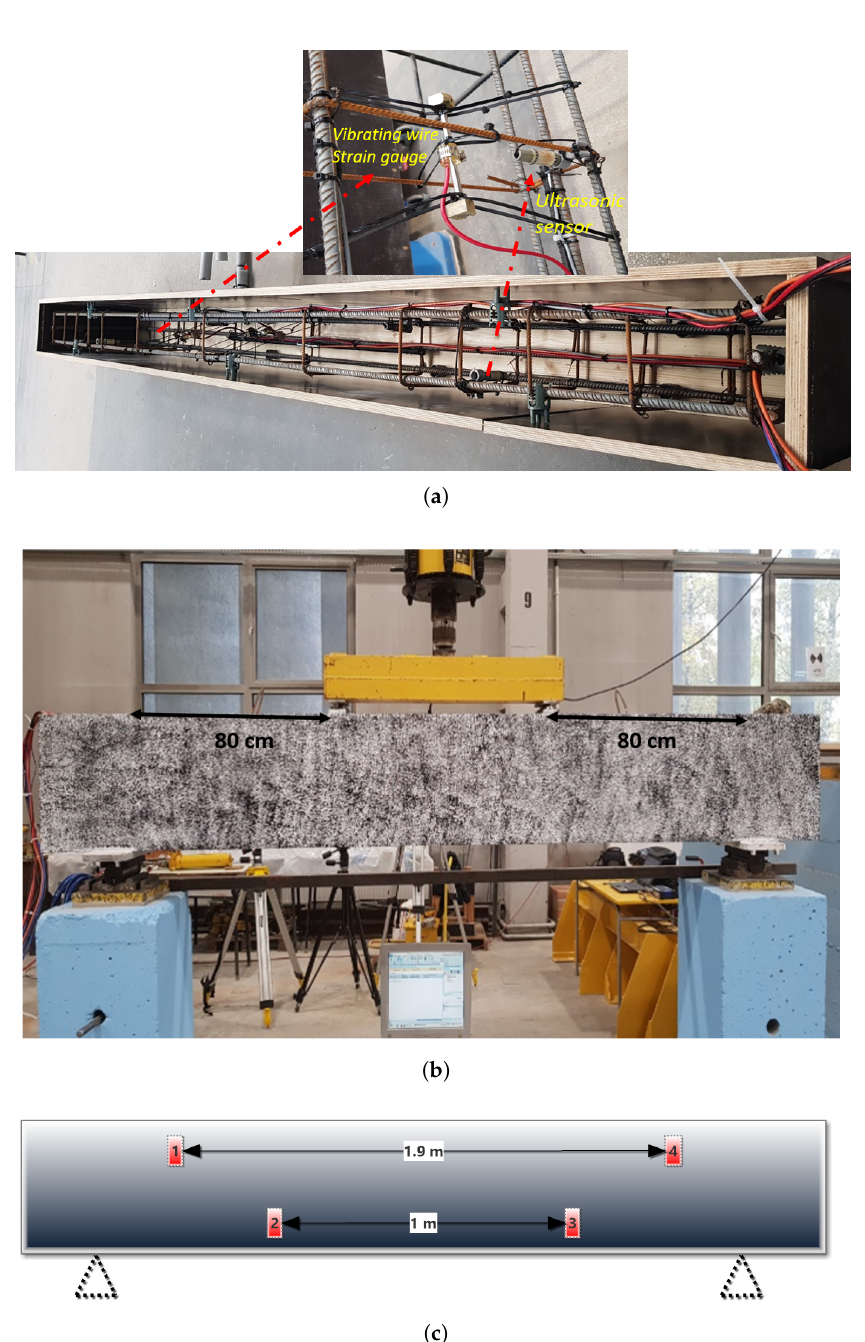
Figure 1. The load position and sensors positions in the beam. ( a ) Ultrasonic sensors embedded with reinforcement; ( b ) Measuring stand and beam load position; ( c ) Ultrasonic sensor position inside the beam. The center frequency of that sensor is around 62 kHz. The exemplary signal in the time and frequency domain is shown in Figure